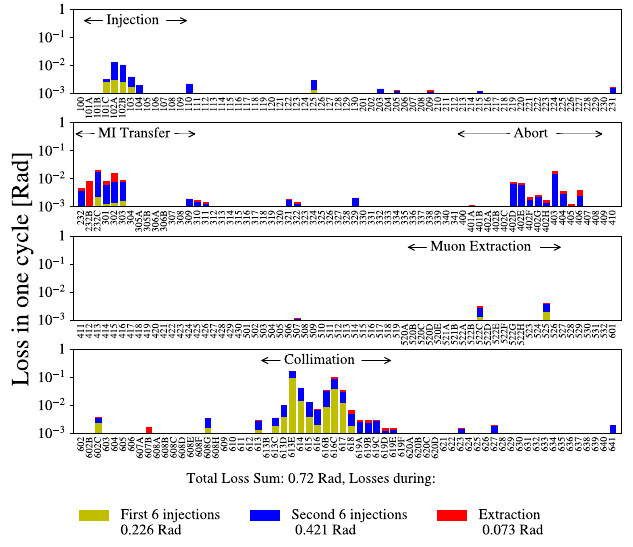
FIG. 11. A typical Recycler loss pattern after the aperture improvements. Intensity is around 50 × 10 12 ppp.